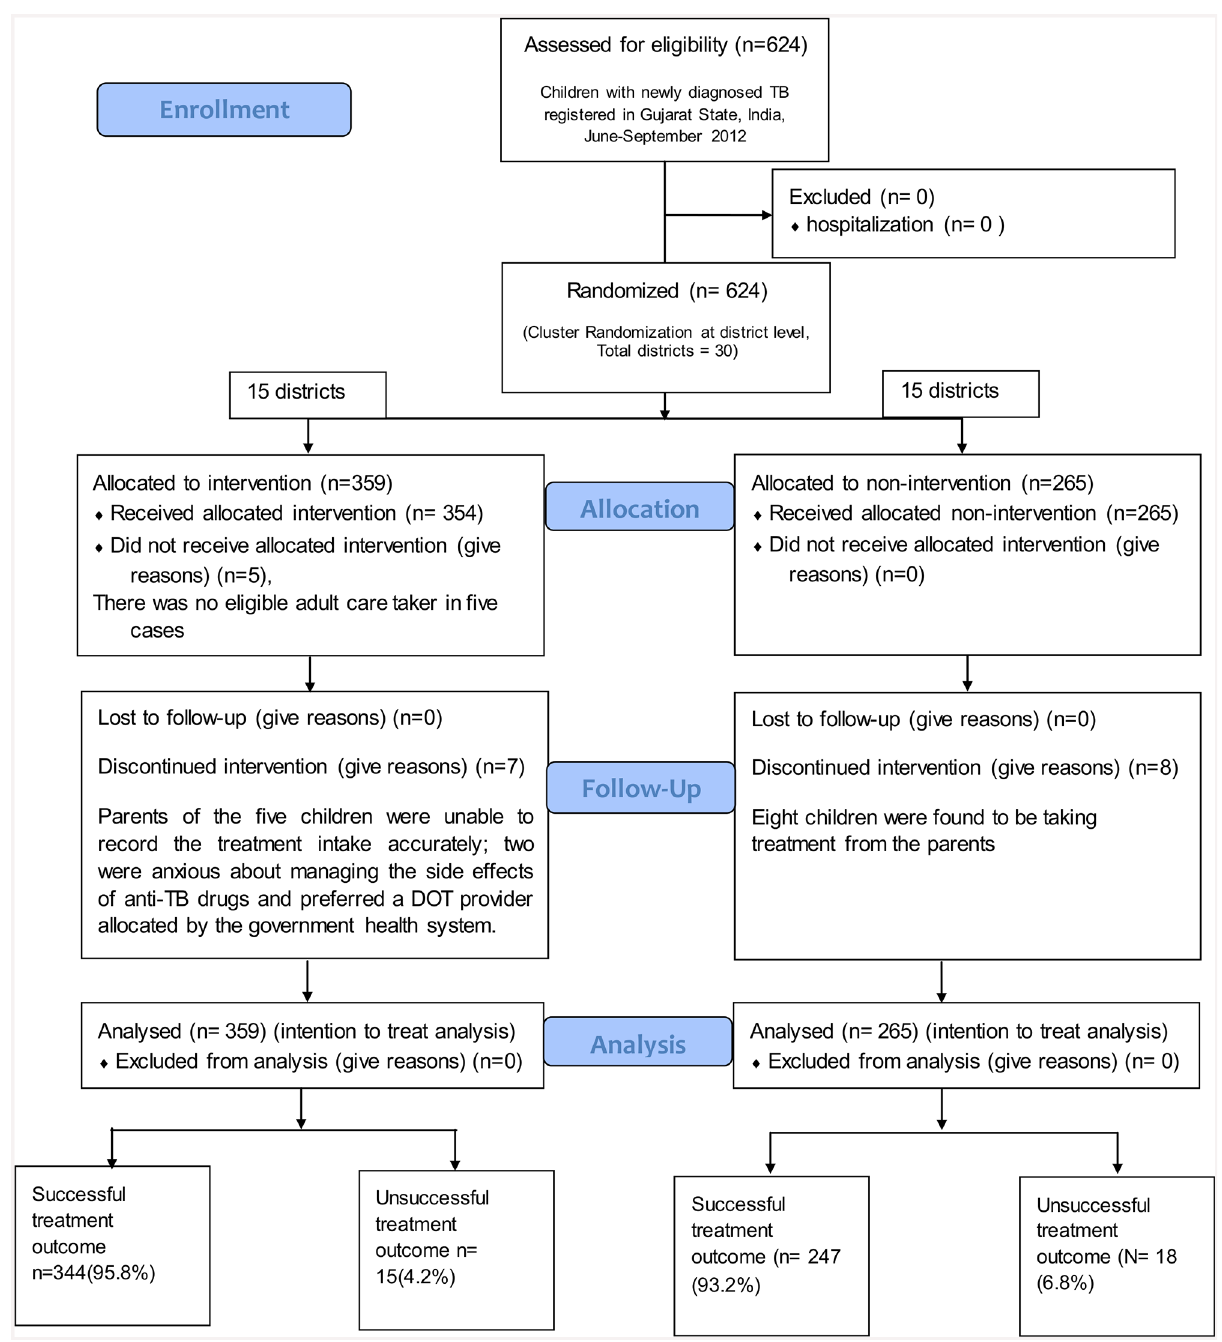
Fig 1. Flow diagram of study cohort of children with newly diagnosed TB registered in Gujarat State, India during June-September 2012.